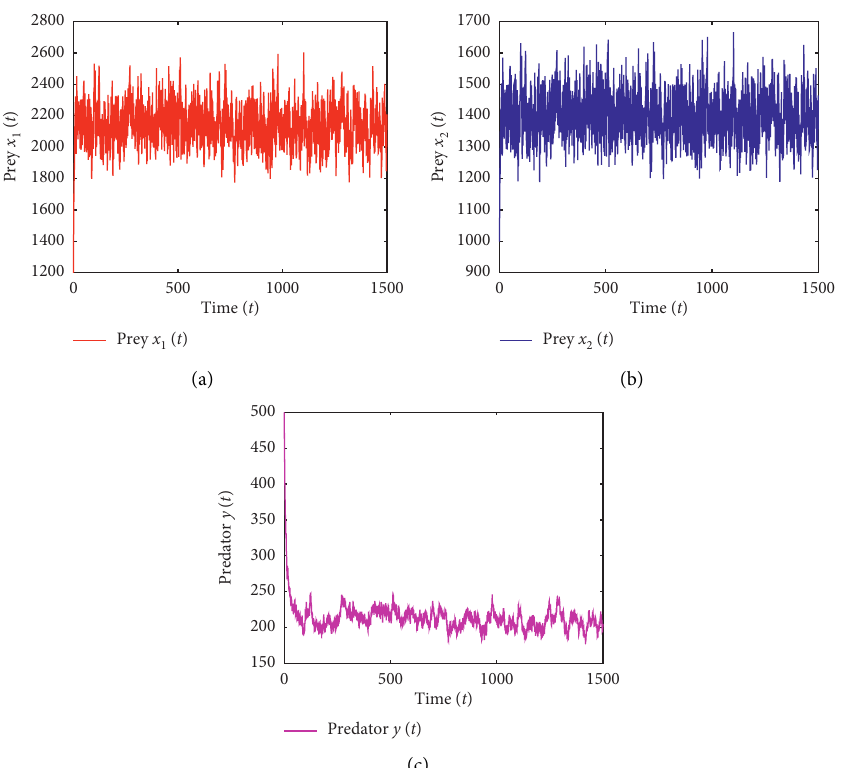
Figure 6: The trajectories of stochastic model (5) with σ and (c) predator y ( t ) .